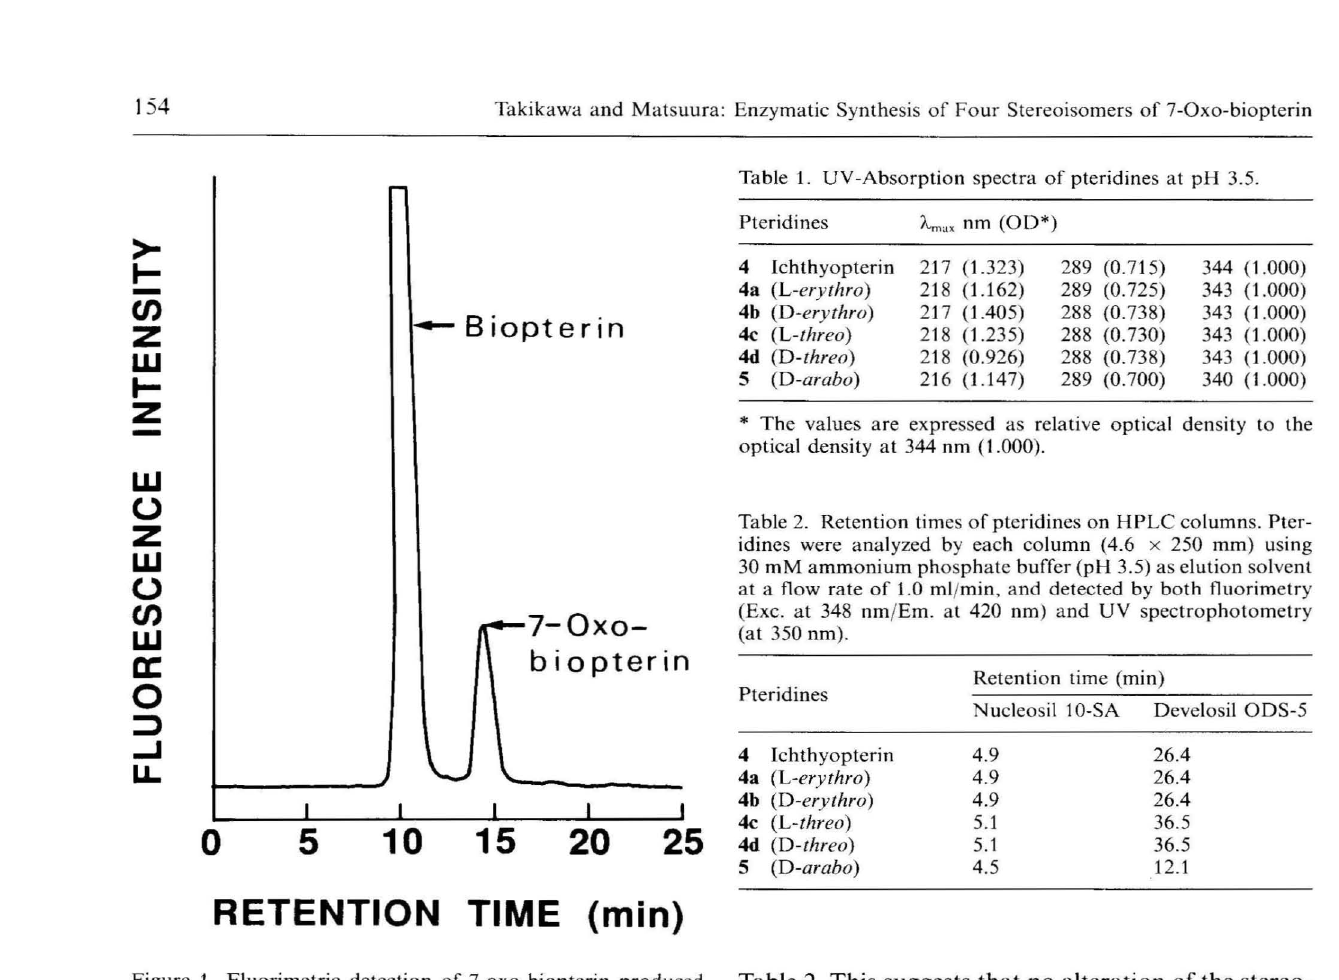
Table 1. UV -Absorption spectra of pteridines at pH 3.5. Pteridines